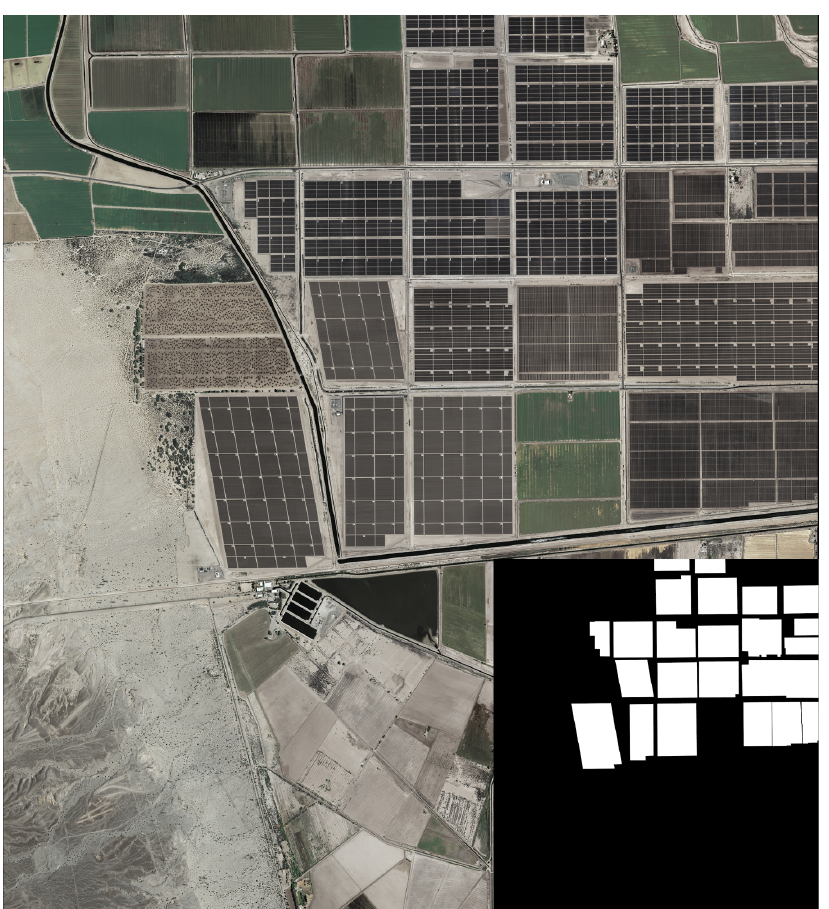
Figure A1. Mount Signal Solar (32 ◦ 40 (cid:48) 24 (cid:48)(cid:48) N, 115 ◦ 38 (cid:48) 23 (cid:48)(cid:48) W) in Imperial county, California, along with its corresponding hand-labeled “ground truth”.